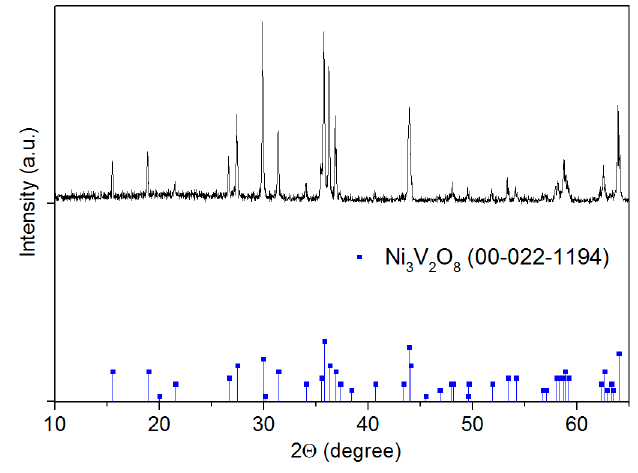
Figure 2. XRD patterns for Ni 3 V 2 O 8 powder sintered at 1000 °C for 2